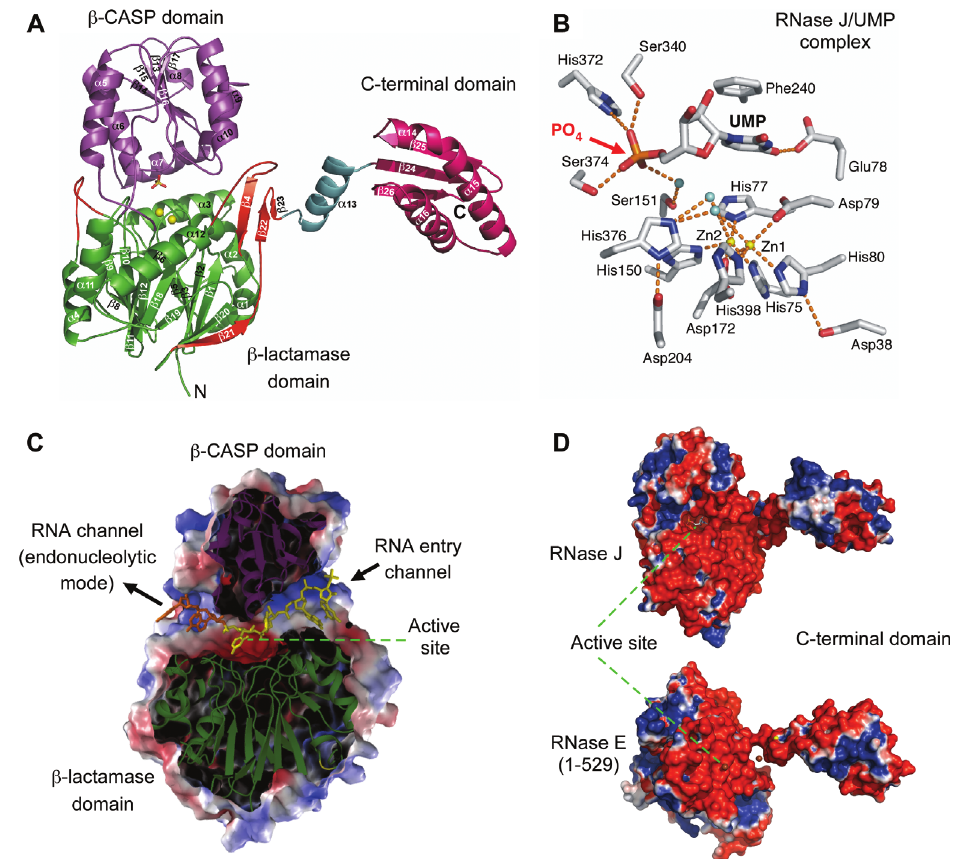
Figure 3 Structure of T. thermophilus RNase J and close-up of the active site (20). (A) Structure of the RNase J monomer. The yellow spheres represent the two Zn q 2 ions in the active site. N and C indicate the N- and C-terminal ends of the protein, respectively. (B) The catalytic center of RNase J complexed with a UMP residue. Dotted orange lines indicate ligand-mediated and hydrogen bond interactions. (C) Slab view of RNA binding channels (47). Positively charged surfaces are shown in blue; negatively charged surfaces are shown in red. The bound 4nt RNA is shown in yellow. Two extra nucleotides (orange) are modeled to show the RNA in endonucleolytic binding mode. (D) Comparison of the electrostatic surfaces of RNase J and the catalytic N- terminal domain of E. coli RNase E. Both structures are presented with the active site facing